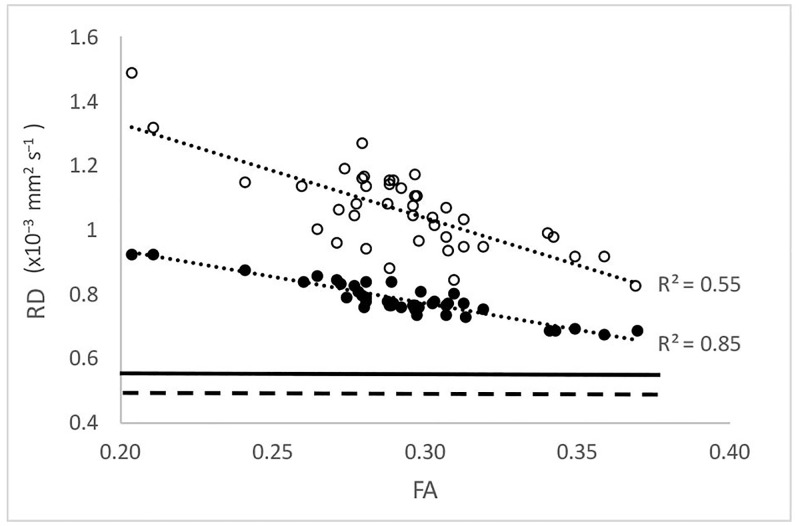
Correlation of observed (empty circles) and normalized (solid circles) RD with fractional anisotropy in MS lesions.The solid horizontal line represents average RD of OR NAWM, the dashed horizontal line average RD of the OR in normal controls.